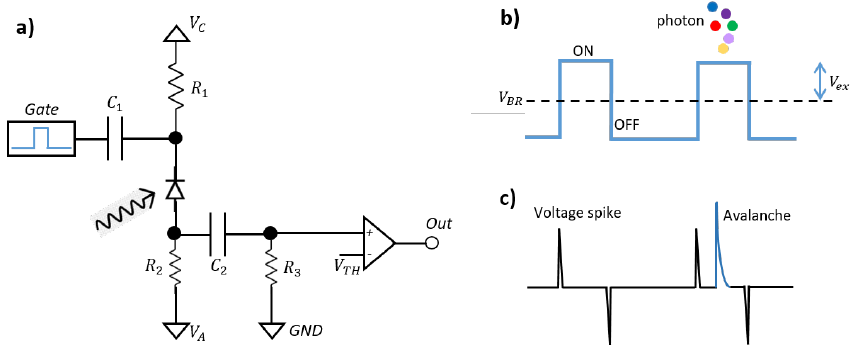
Figure 16. Time-gated operation scheme. ( a ) A basic diagram of a SPAD with a time gated control circuit. ( b ) A timing diagram of the gating signal; ( c ) a timing diagram of the output of the AC pick-up